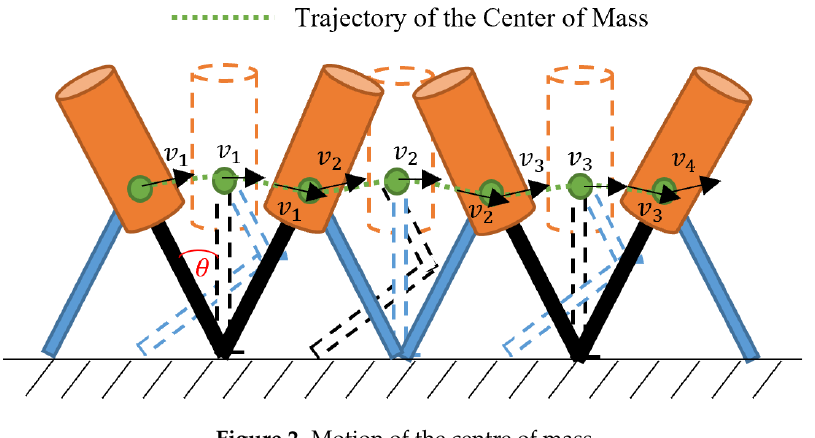
Figure 2. Motion of the centre of